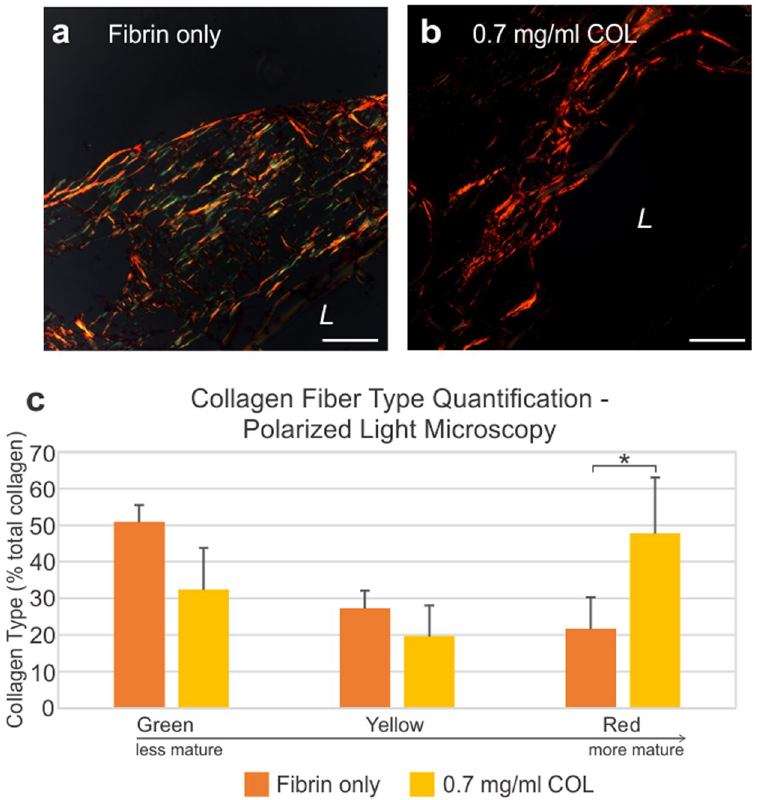
Figure 6. Polarized light images reveal a distinct difference in collagen maturity and fiber thickness between the Fibrin only and 0.7 mg/ml COL rings. ( a ) Rings with fibrin only displayed a mix of green, yellow and a few red fibers indicating a mixed composition of mostly immature collagen and some mature fibers. ( b ) Collagen in 0.7 mg/ml COL rings appeared as mature red fibers. The yellow and green colors signify the presence of thin fibers, and red indicates thick fibers. L = lumen side. Scale bars = 100 µ m. ( c ) Collagen fiber type/maturity were measured using the polarized light images through green, yellow and red fiber quantification. Fibrin only rings exhibited more green fibers indicating less maturity, whereas 0.7 mg/ml COL rings displayed more red fibers indicating more maturity with a statistically significant difference (p ≤ 0.05).